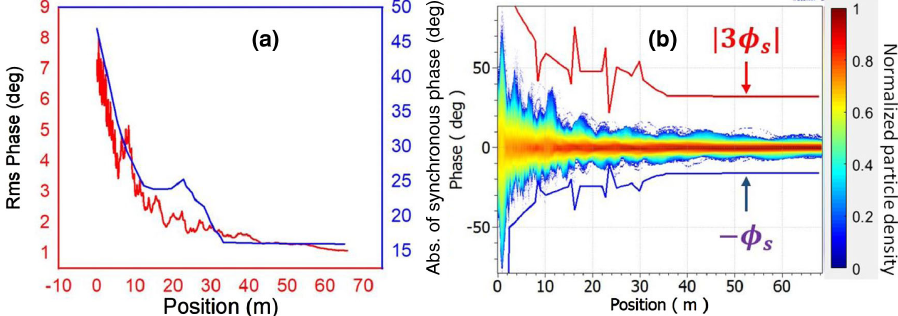
FIG. 35. (a) Variation of rms beam phase and absolute synchronous phase along the linac, and (b) maximum beam phase variation superposed with phase acceptance along the linac.